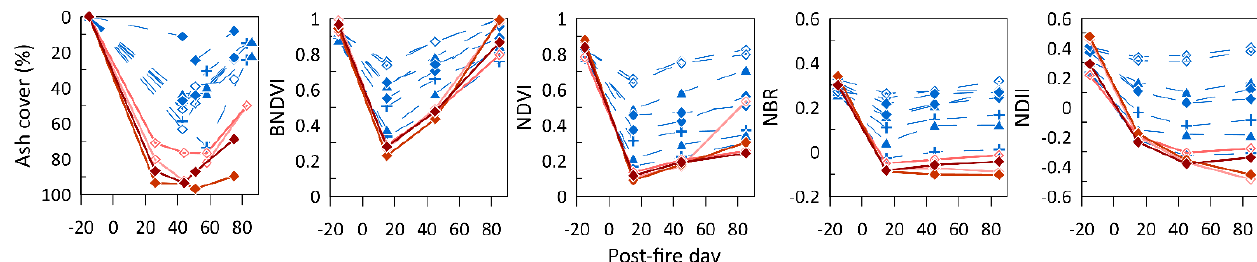
Figure 8. Disturbance indices from Sentinel-2 data over time from the Mesa Fire. Transects T1 and T2 are in red colors and have solid lines to highlight the high-severity (high ash cover) plots as well as to emphasize how the index values and ash cover change over time. The low/moderate plots are in blue. The ash cover y-axis is inverted in the far-left panel to ease the comparison to the spectral indices.